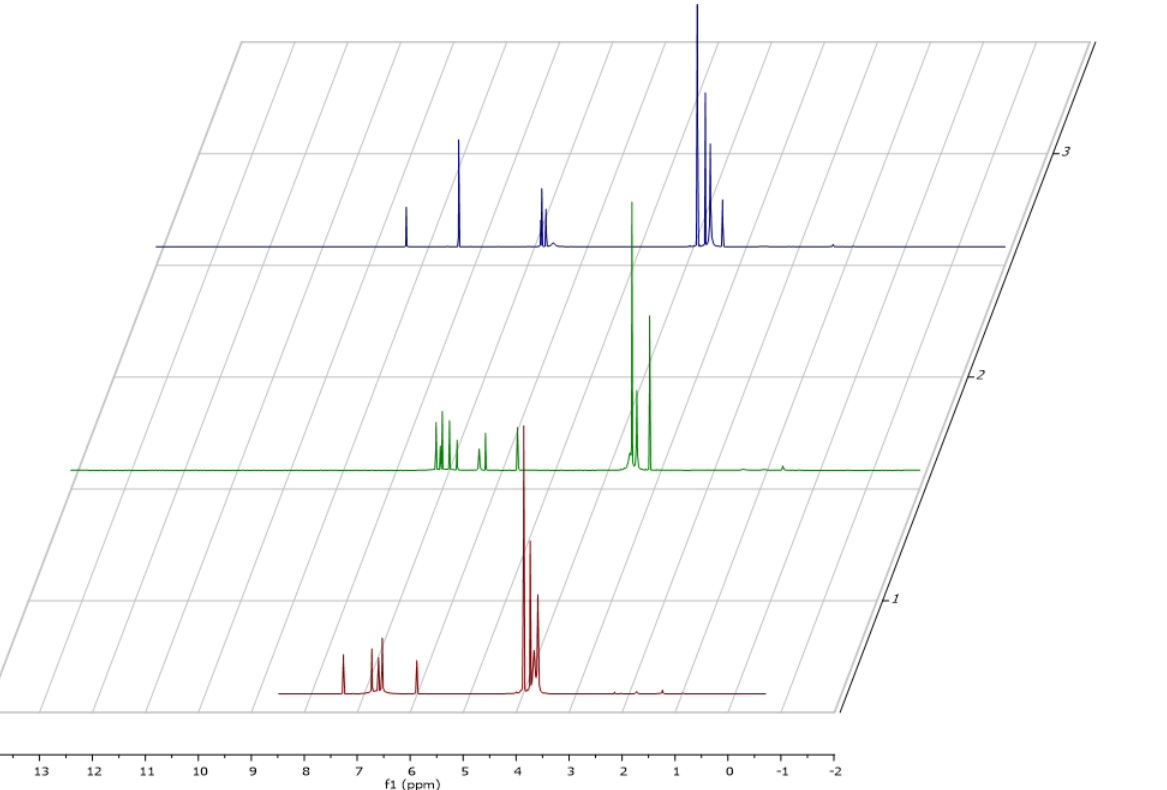
Figure 3. NMR Spectra of the intermediate 15 in di ff erent solvents; CDCl 3 ( red ), toluene-d 8 ( green ), DMSO-d 6 ( blue ) at room